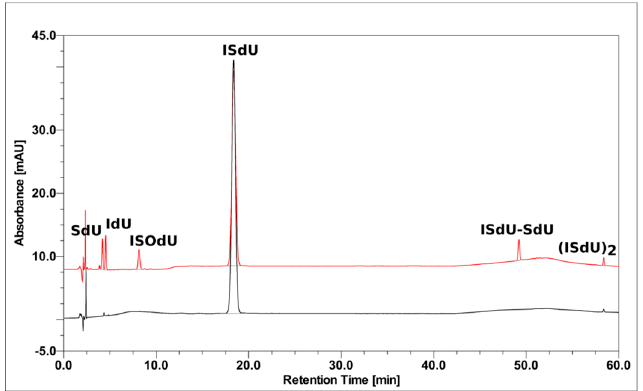
Figure 1. HPLC traces for a solution of 5-iodo-4-thio-2 ′ -deoxyuridine (ISdU) before (black chromatogram) and after irradiation with a dose of 140 Gy (red chromatogram).